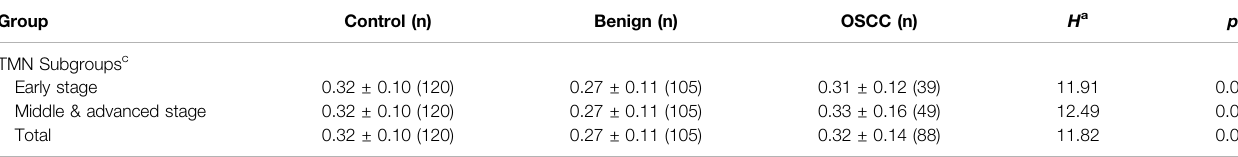
TABLE 2 | The levels of plasma IgG against HER2 among three different groups.